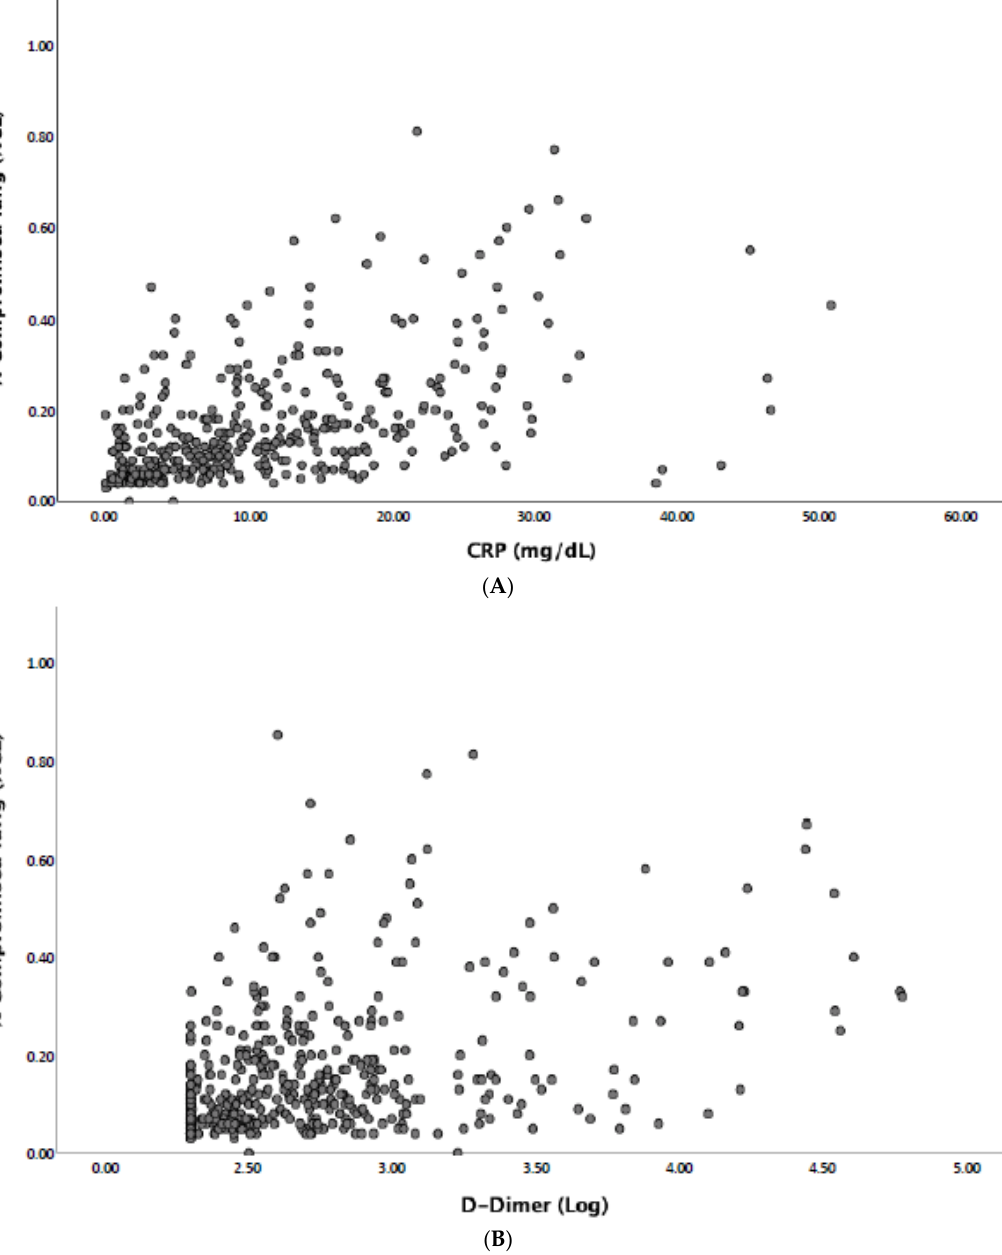
Figure 2. Scatter plot of the distribution of CRP (( A ); r 2 = 0.58, p < 0.001) and log D-dimer (( B ); r 2 = 0.36, p < 0.001) levels according to %CL values in the study population.